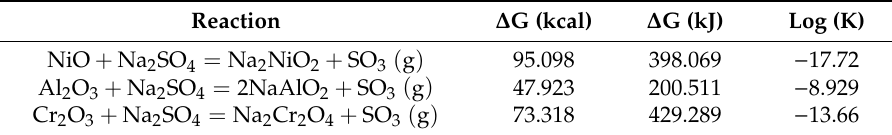
Table 3. The thermodynamic parameters of three oxides reacted with molten salt at 900 ◦ C. Reaction ∆ G